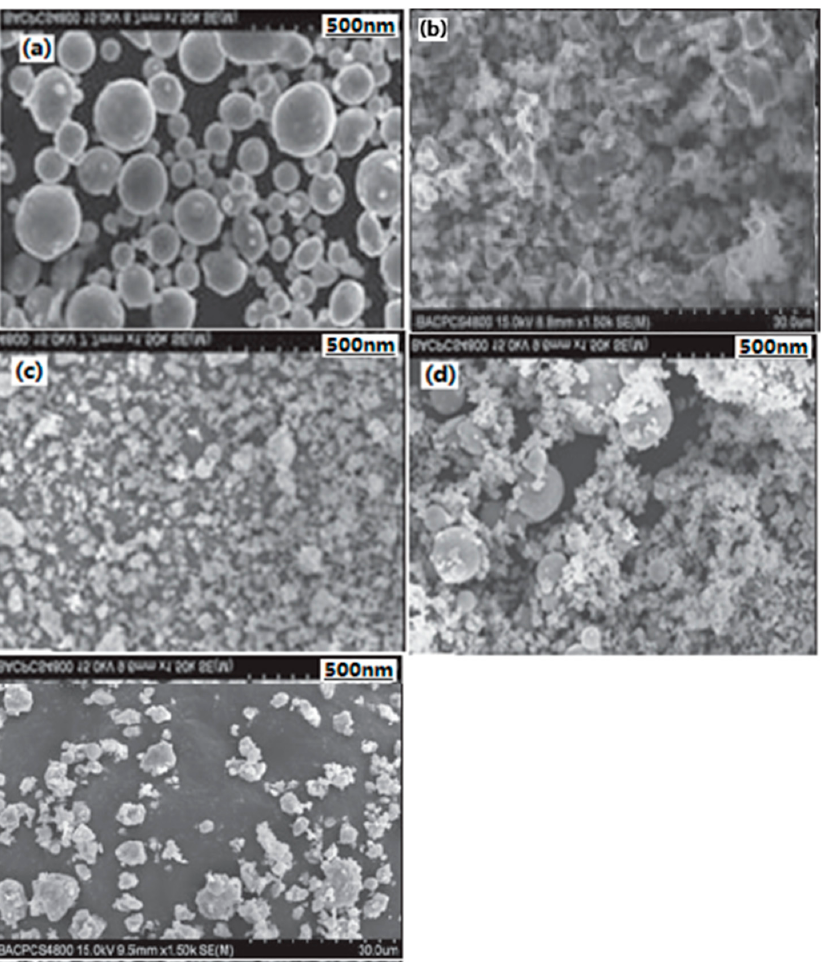
Figure 9. SEM photographs of different samples. ( a ) Raw Al; ( b ) raw B; ( c ) Al/B composite; ( d ) physical mixed; and ( e ) ball milling. Reproduced from [48], with permission from Gu Ti Huo Jian Ji Shu, 2014.